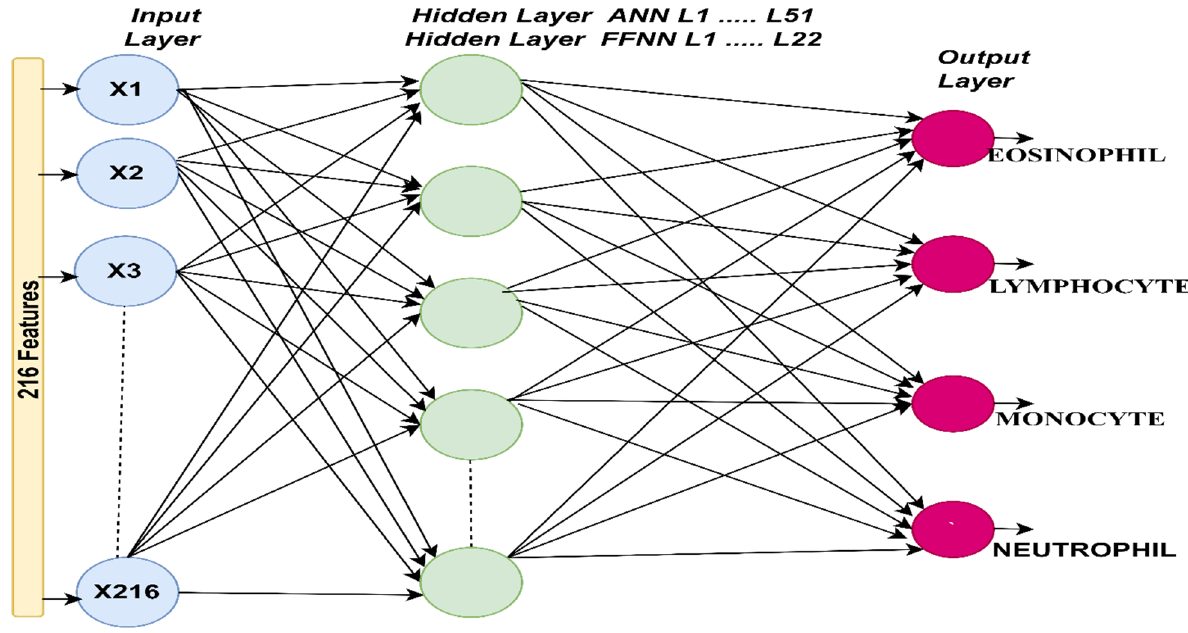
Figure 6. The basic structure of ANN and FFNN.